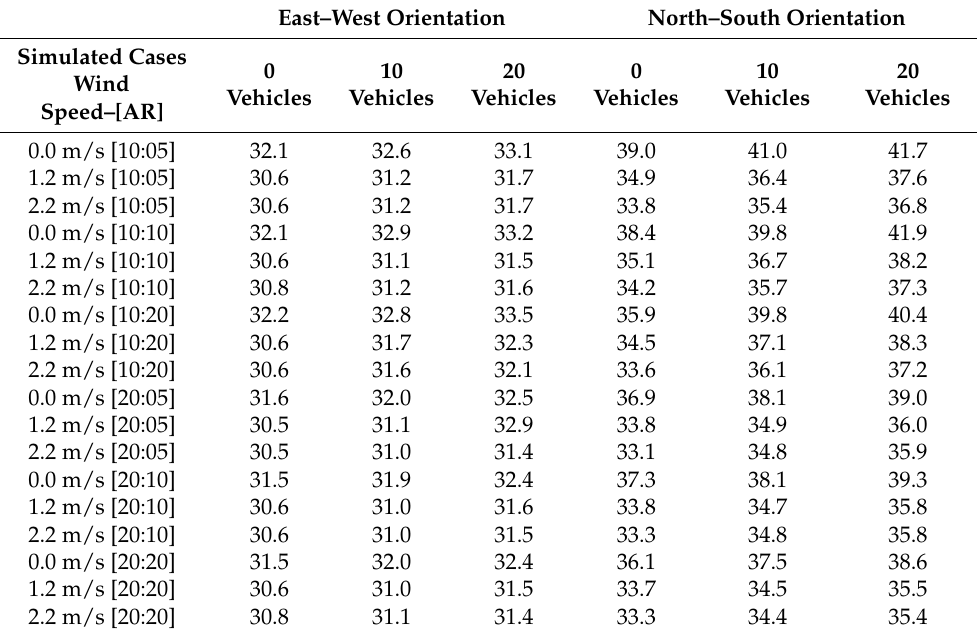
Table 4. Modeled data with wind speed variations vs street orientation for each aspect-ratio [AR]. Values in ◦